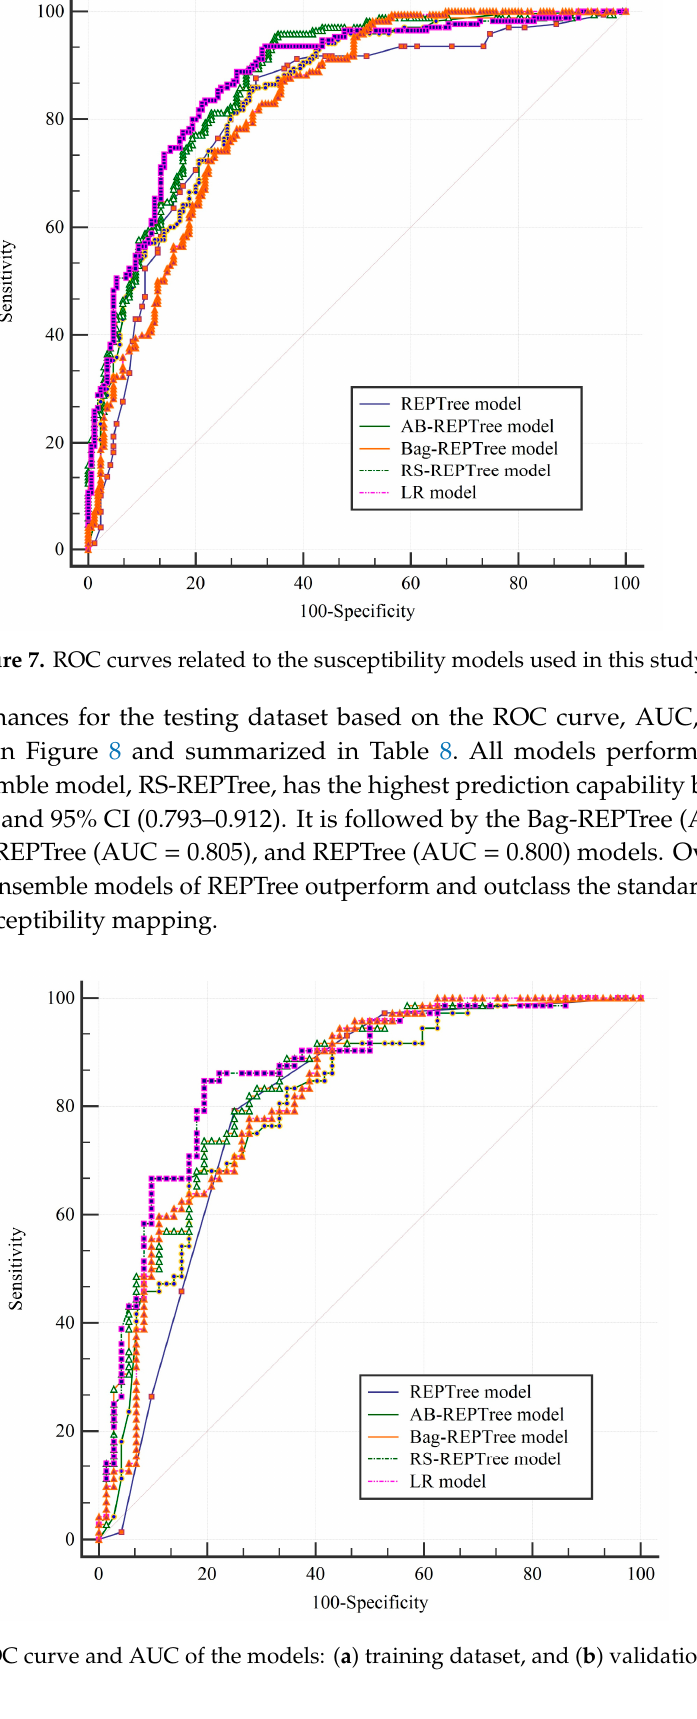
Table 7. ROC curve using the validation dataset 414